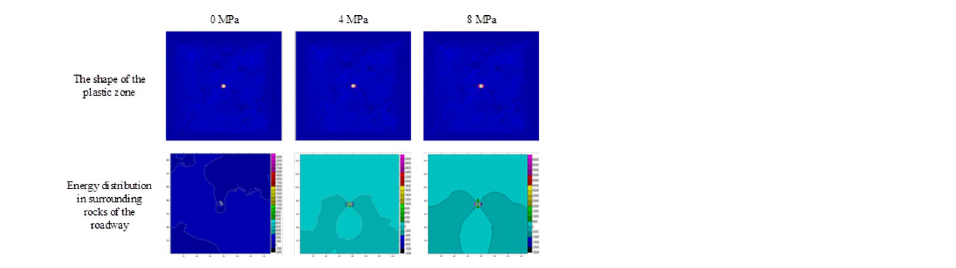
Fig 4. The shape of the plastic zone and the energy distribution of the surrounding rock of the roadway under the abutment pressure of 0~8MPa.